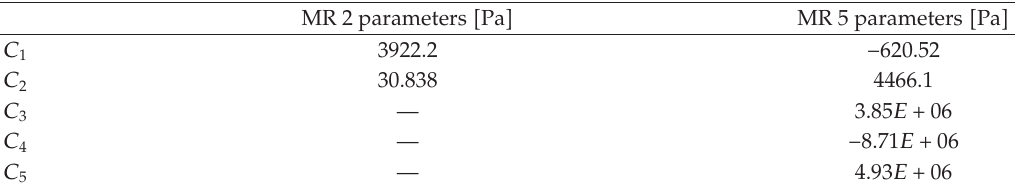
Table 2: Mooney-Rivlin